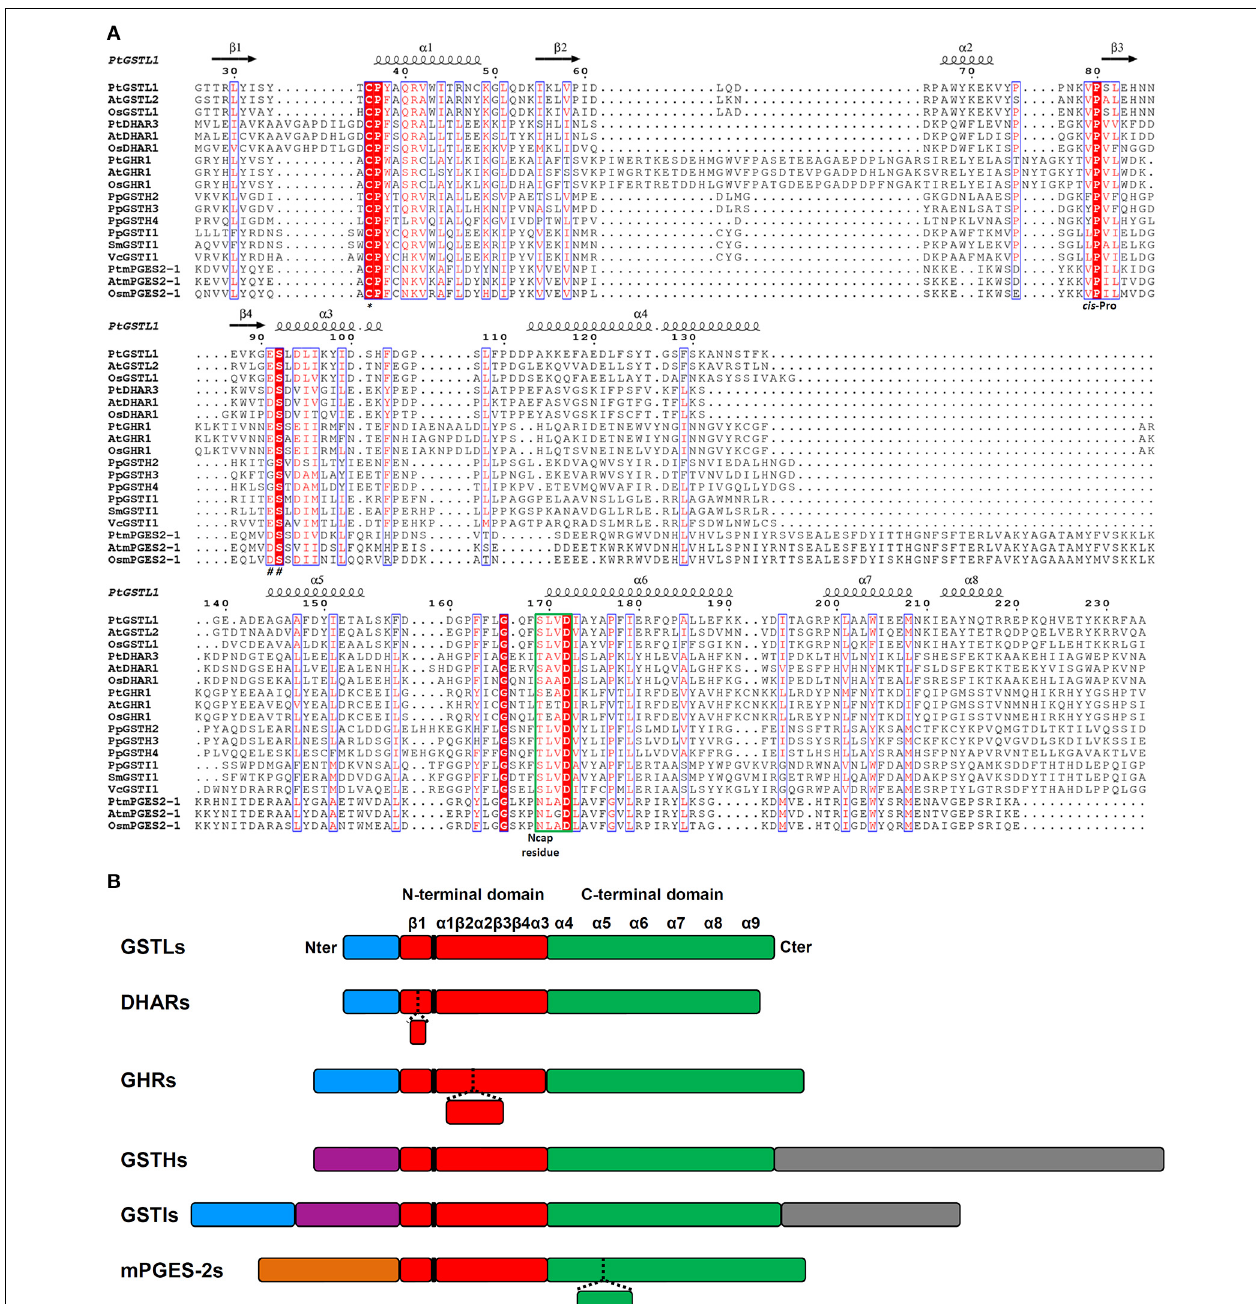
FIGURE 3 | Amino acid alignment and protein architecture of plant Cys-GSTs. (A) Amino acid sequence alignment of three representative members from each Cys-GST class. The sequences were structurally aligned using PROMALS3D server using as references the solved structures of PtGSTL1 [PDB code 4PQH (Lallement et al., 2014)], PtGSTL3 [PDB code 4PQI (Lallement et al., 2014)], Phanerochaete chrysosporium GHR1 [PDB code 3PPU (Meux et al., 2011)], and Macaca fascicularis mPGES-2 [PDB code 1Z9H (Yamada et al., 2005)] since there is no structure available for DHARs, GSTIs, and GSTHs. Since the structure of poplar GSTL1 has been solved, its secondary structures have been indicated as reference using ESPript 3.0 (http://espript . ibcp . fr/ESPript/ESPript/index . php), with the helices and the arrows corresponding respectively to α -helices and to β -strands. Strictly